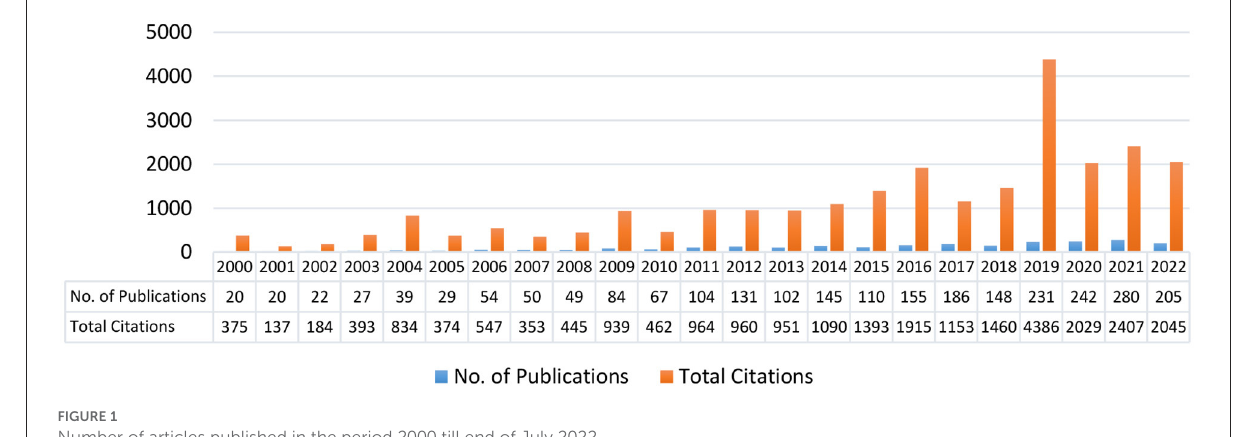
FIGURE1 Number of articles published in the period 2000 till end of July